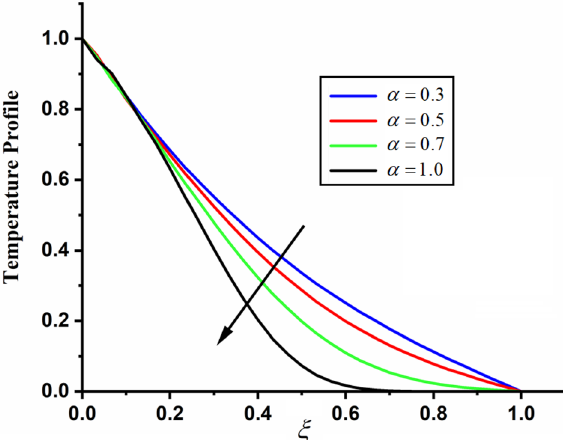
Figure 12. The impact of α on the temperature of couple stress fluid when, β = 0.5 , Re = 3.2 , t = 0.2 and Pr = 0.5 .